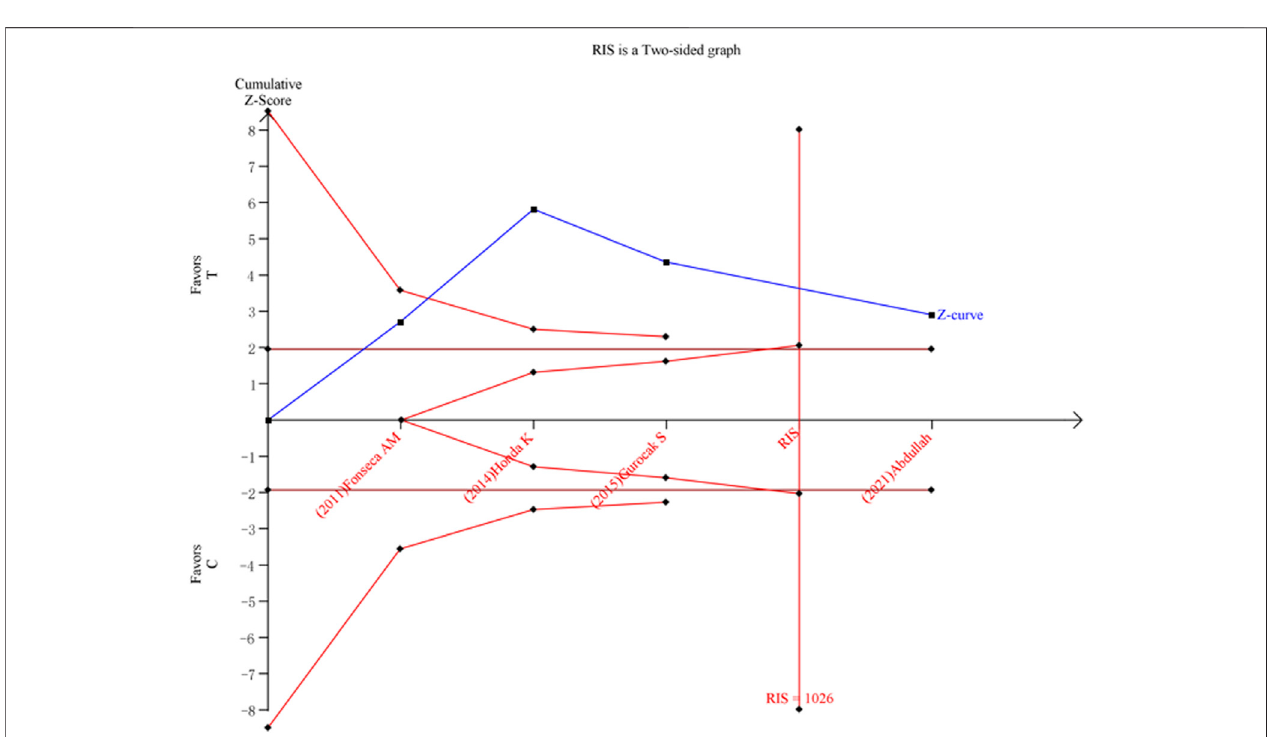
FIGURE 3 | Result of TSA for the association between ADRB3 gene polymorphism and susceptibility to OAB in the allele model (C vs.